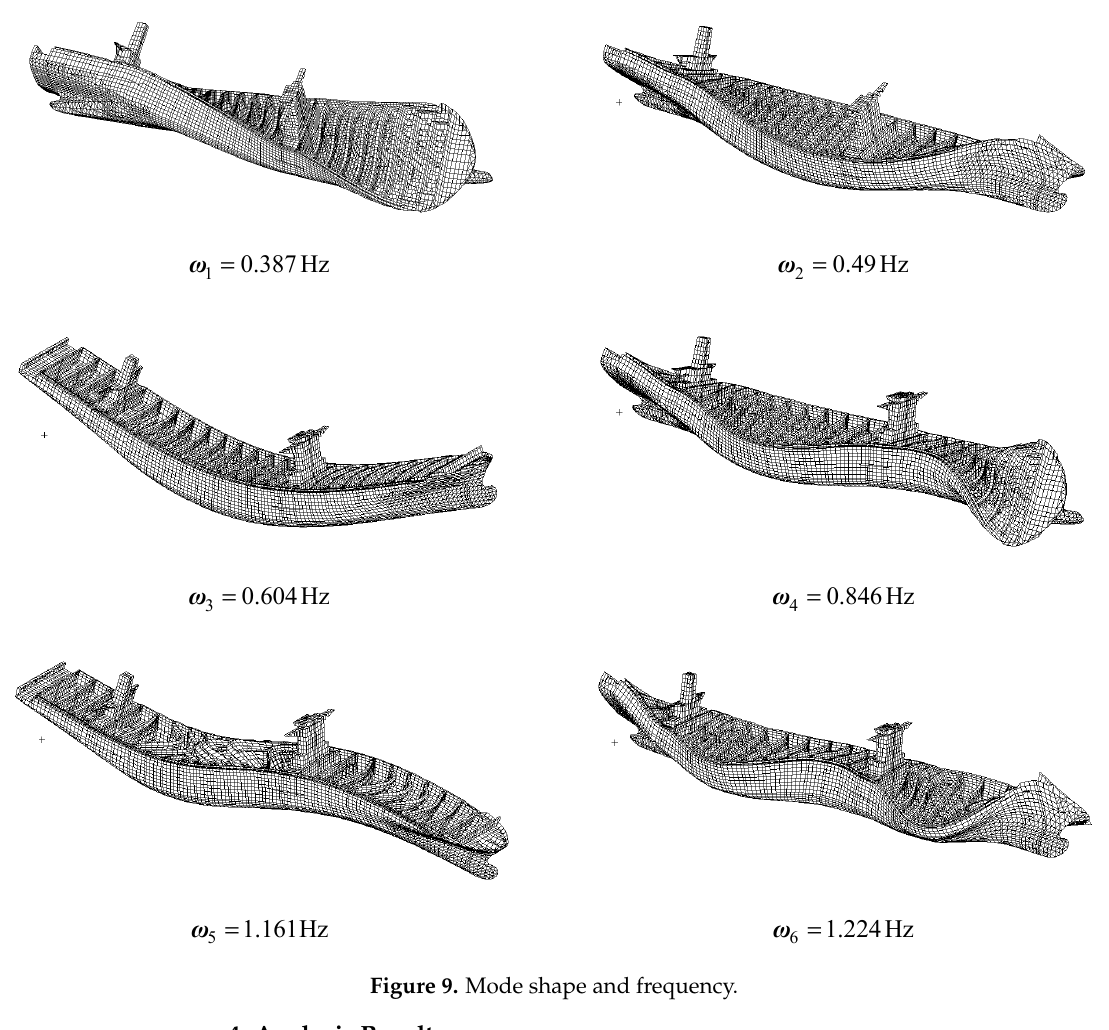
Figure 9. Mode shape and frequency.